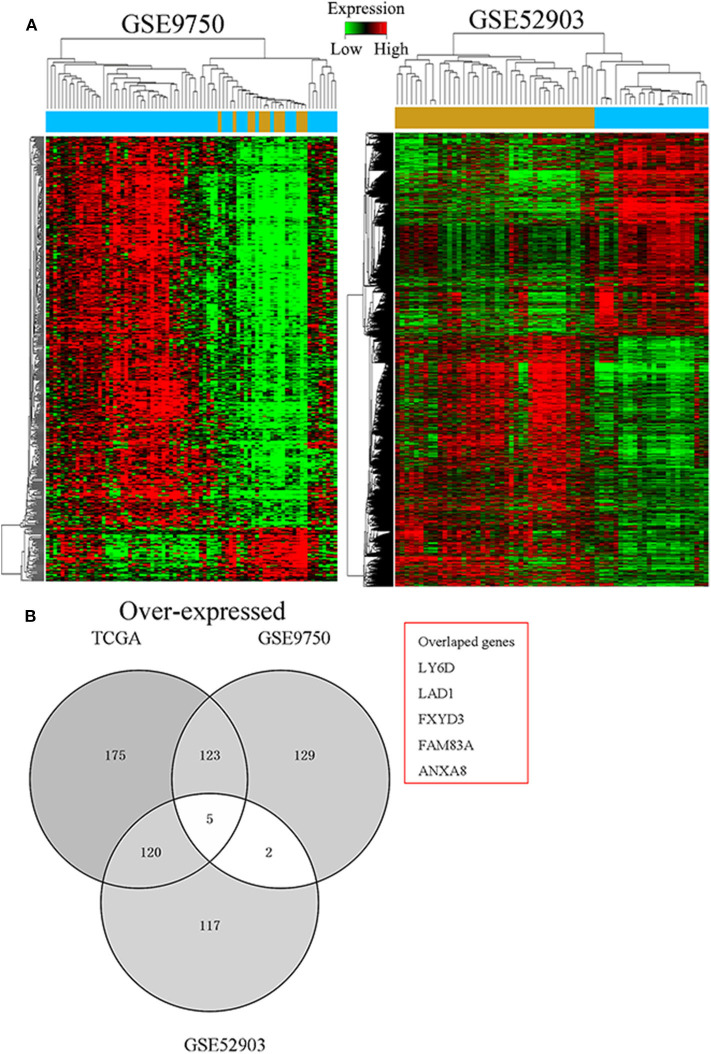
Identification of FAM83A as a cervical cancer-specific gene. (A) Hierarchical clustering analysis of genes that were differentially expressed (fold change > 4; q < 0.05) in cervical cancer and normal tissues. (B) Overlap of aberrantly expressed genes in the TCGA CESC data and GEO datasets.